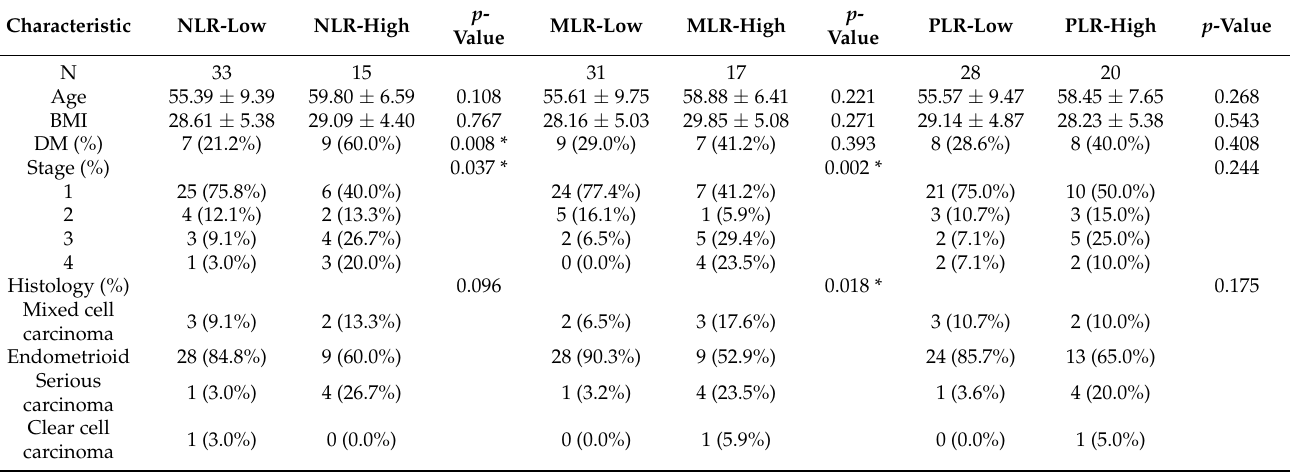
Table 3. Clinical and pathological characteristics of patients with EC in high and low NLR/MLR/PLR groups ( n =